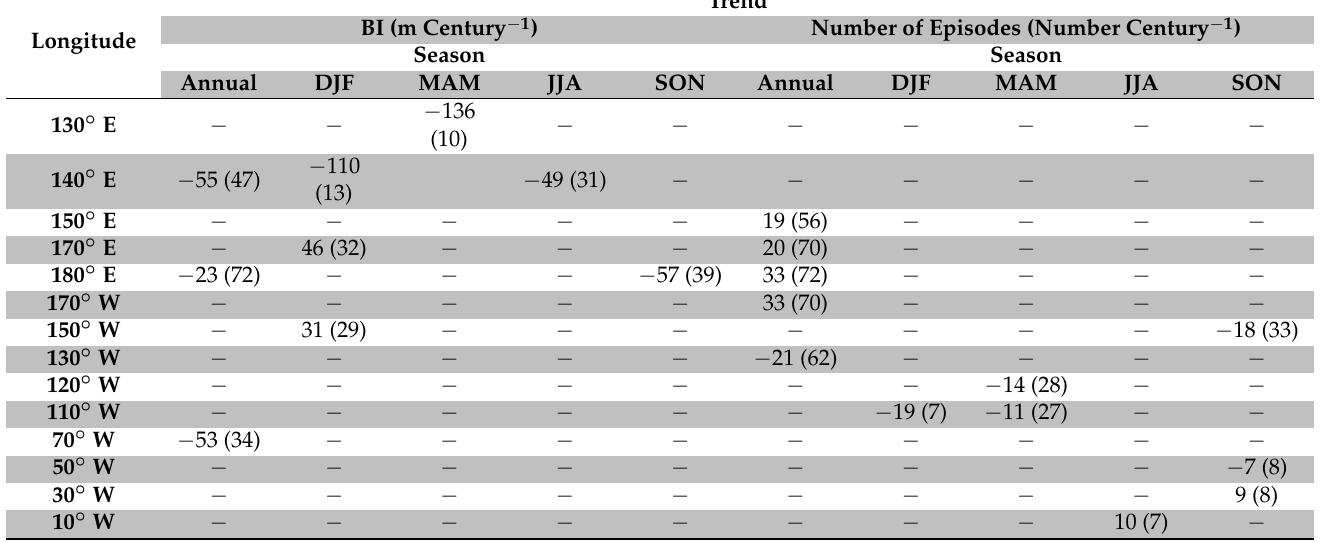
Table 3. Linear trends in the annual and seasonal time series of the BI and of the number of individual episodes for every 10 ◦ of longitude. All trends shown are significant to a 95% confidence level. The number of elements in each time series is shown in parenthesis. Longitudes at which no significant trends were detected are